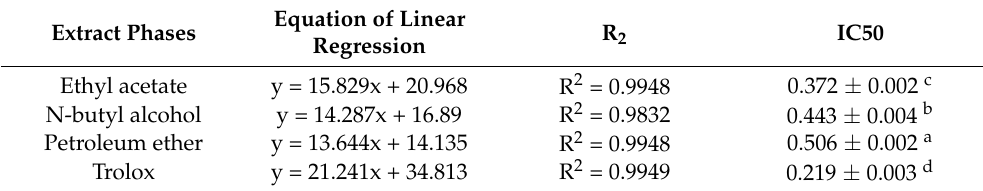
Table 12. FRAP values of Pleioblastus amarus (Keng) shell with different extraction phases.